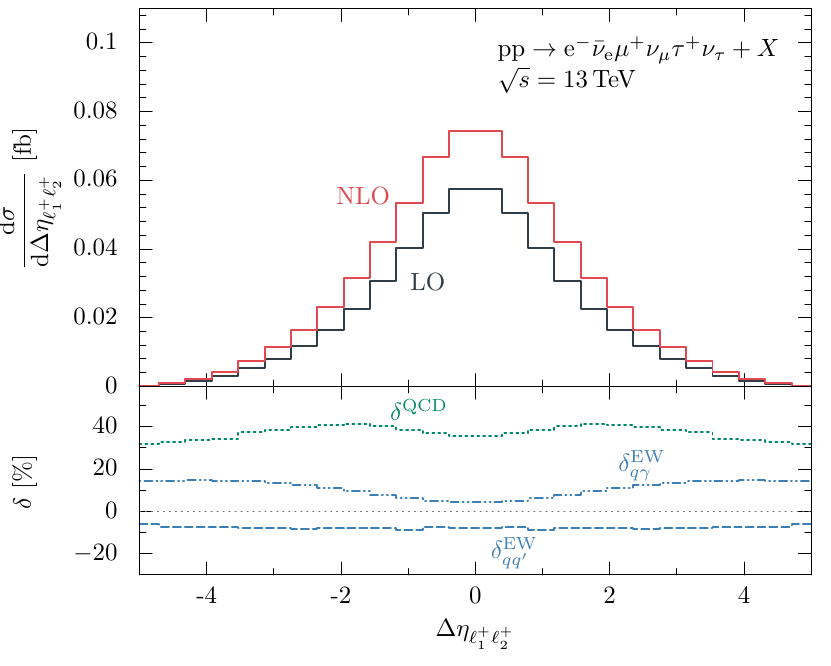
Figure 10. Di(cid:11)erential distribution in the di(cid:11)erence of the pseudorapidities of the two positively charged leptons, (cid:1) (cid:17) ‘ + 1 ‘ + 2